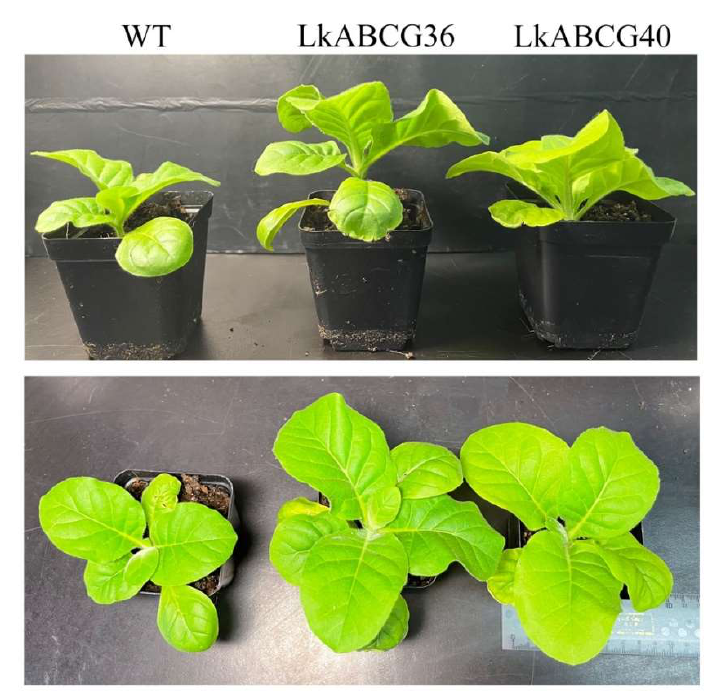
Figure 1. Overexpression of LkABCG36 and LkABCG40 promoted tobacco plant growth. Morphology of wild type (WT) and transgenic (LkABCG36 and LkABCG40) tobacco plants at 11 weeks old.